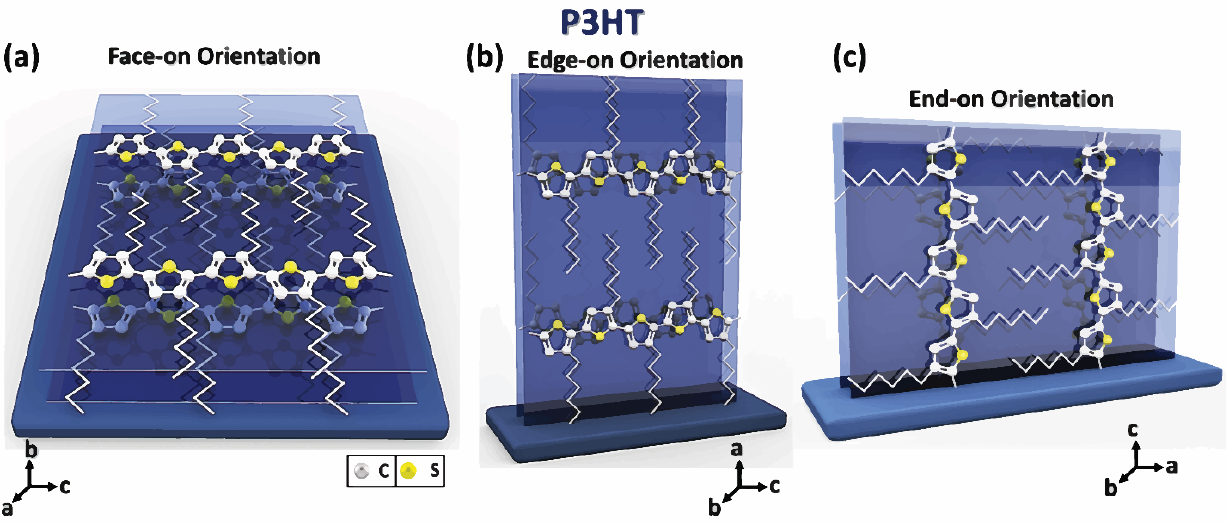
Figure 9. Schematic representation of three different orientations in the P3HT polymer: ( a ) face ‐ on orientation; ( b ) edge ‐ on orientation; and ( c ) end ‐ on orientation [1]. ( a – c ) Reproduced with permission [1]. Copyright 2020,